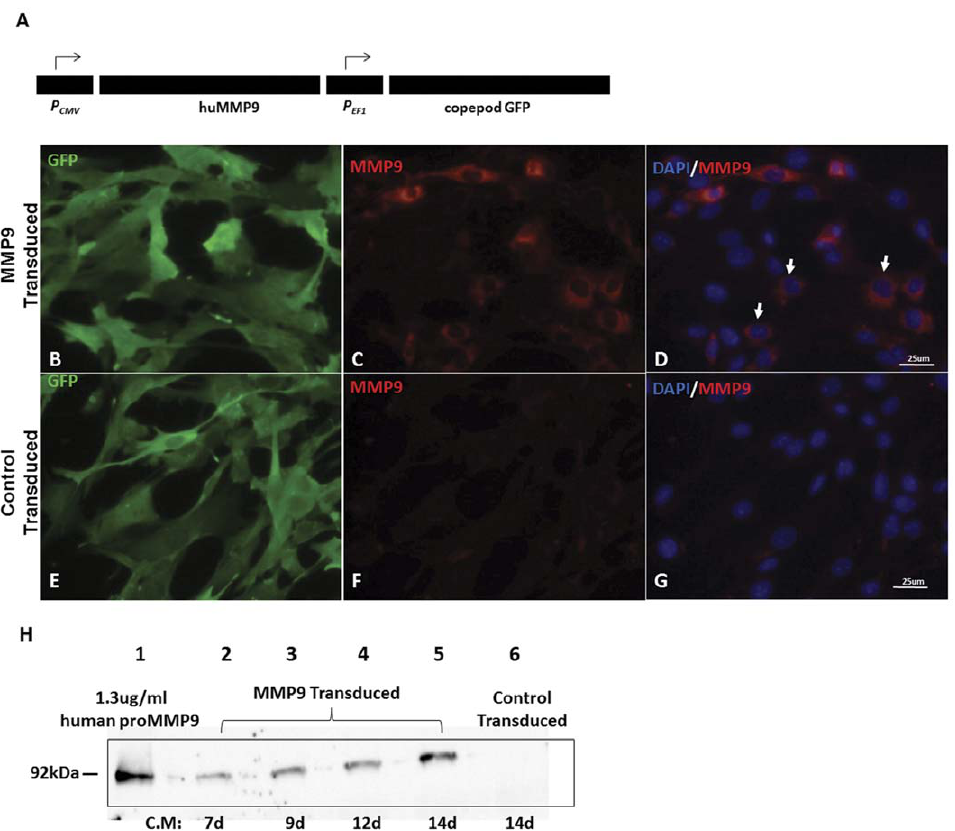
Figure 2. Expression and secretion of MMP9 in cultured NSCs. Cells were transduced with Lentiviruses that confer cytomegalovirus (CMV) directed human MMP9 expression (A). MMP9 immunoreactivity was robustly detected in cells transduced with the MMP9 virus (B–D). Arrow indicates MMP9 expressing cells with little detection in cells transduced with GFP only virus (E–G). Immunoblots of medium from cultured cells demonstrated secretion of human MMP9 into the medium (H). Each lane contains 18 m L of conditioned medium from cells incubated for 7–14 days. Lane 1 was loaded with 18 m L of a 1.3 m g/mL solution of purified human MMP9 proenzyme.